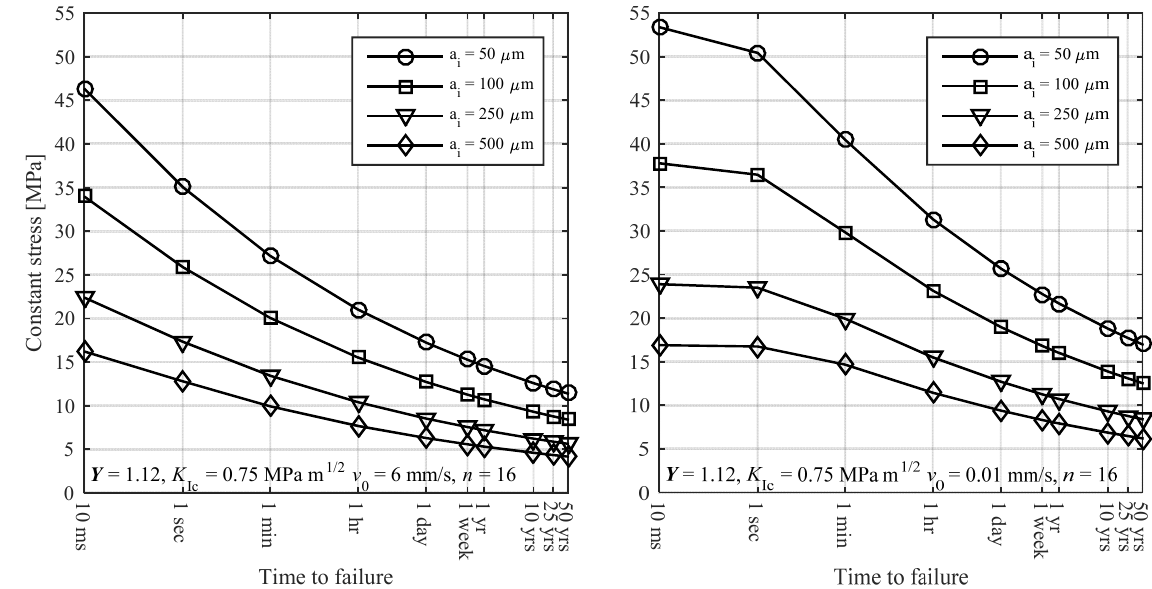
Time to Fig. 7 The time-dependent strength of a crack for a number of different initial crack depths (cid:1853) (cid:3036) according to the lifetime prediction model of Haldimann (2006).